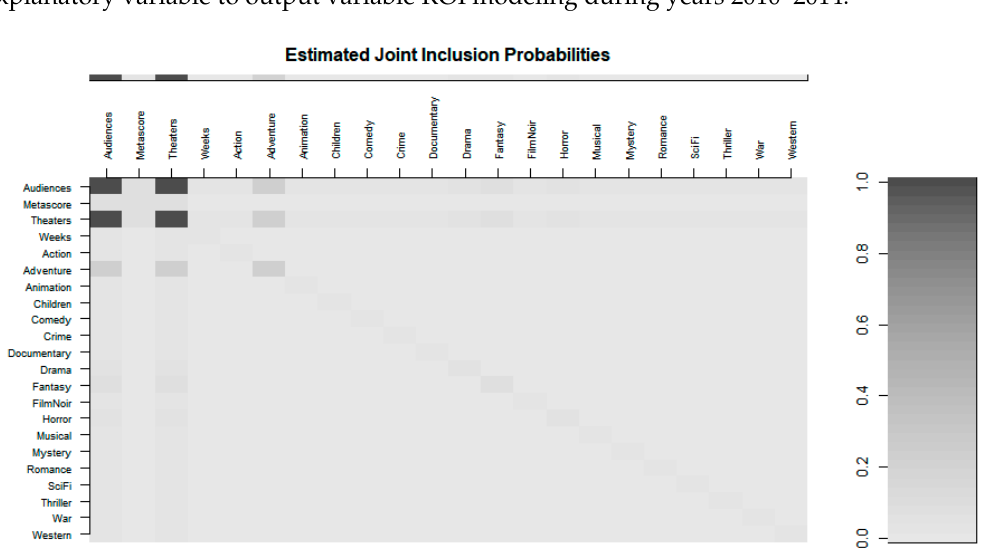
Figure 4. Bayesian variable selection of ROI with Movie Data (2010–2014). Table 7. Bayesian variable selection of ROI with Movie Data (2010–2014).